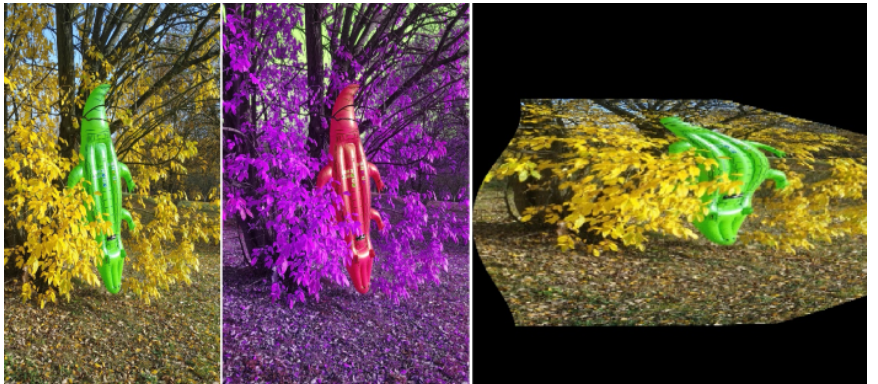
Figure 4. Example of an image modification. From left to right: original image, RGB channels remapping, random distortion matrix application (extreme example for better visibility).